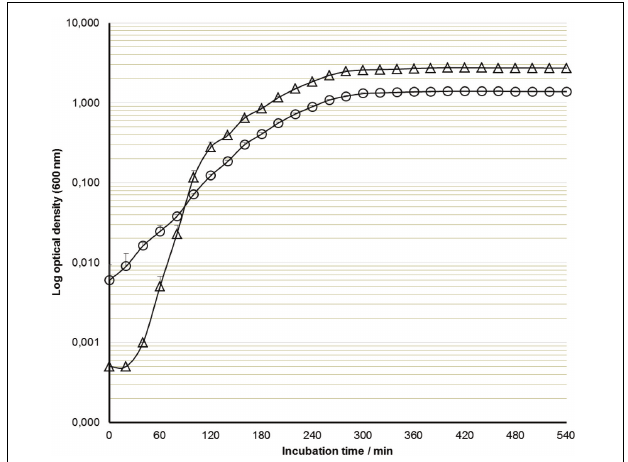
FIGURE 2 | Growth curves of Escherichia coli obtained by measuring the OD at 600 nm in the miniaturized setup (optical path of ∼ 16 mm) (triangles), and the benchtop UV-Vis spectrophotometer (optical path of 10 mm) (circles). Results are means and standard deviation from three cultures.